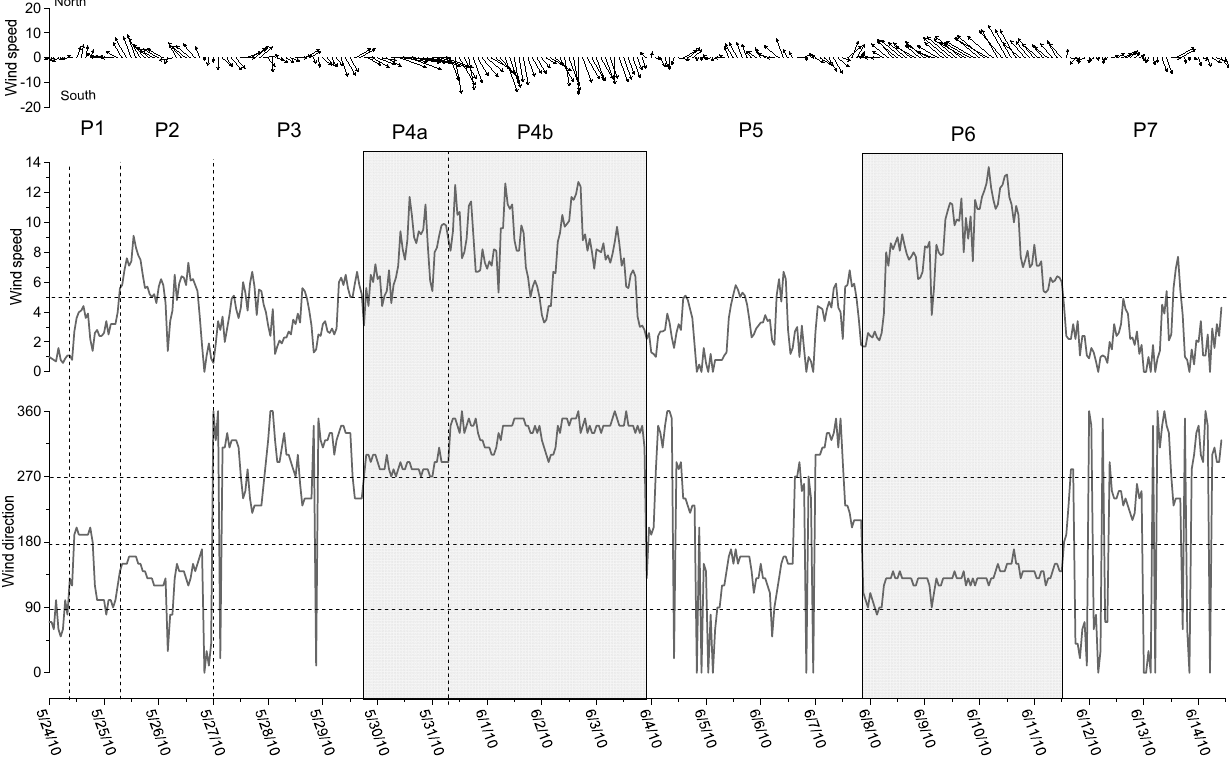
Figure 9. Measured wind vectors, wind speed and wind direction measured at the meteorological station B. Wind direction is defined as the direction from which the wind is